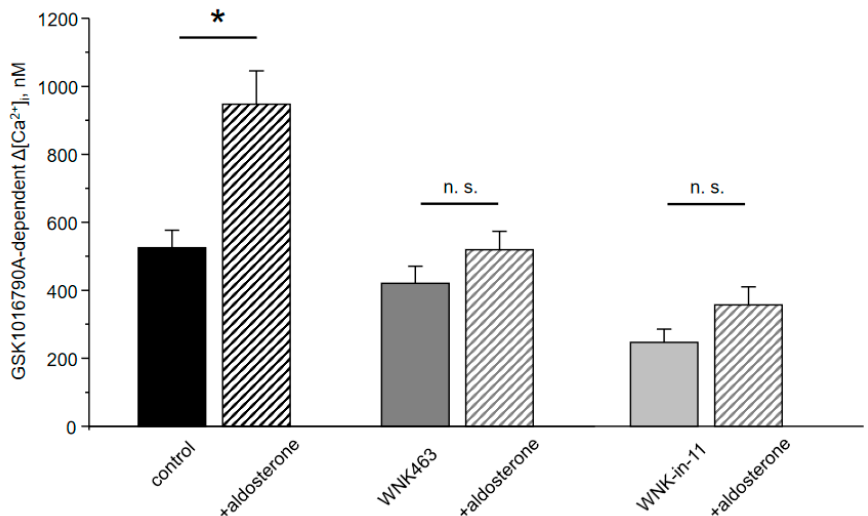
Figure 5. Inhibition of WNK1 abolishes regulation of TRPV4 activity by aldosterone in mpkCCD c14 cells. Summary graph comparing the magnitudes of GSK1016790A-mediated [Ca 2+ ] i elevations calculated as the difference in [Ca 2+ ] i values before and after application of the TRPV4 agonist in individual mpkCCD c14 cells kept on control conditions and treated with aldosterone, pan-specific WNK blocker WNK463, and selective WNK1 inhibitor WNK-in-11 as indicated. *—significant difference ( p < 0.05) or n.s.—non-significant difference ( p > 0.05) between groups is indicated with a line.